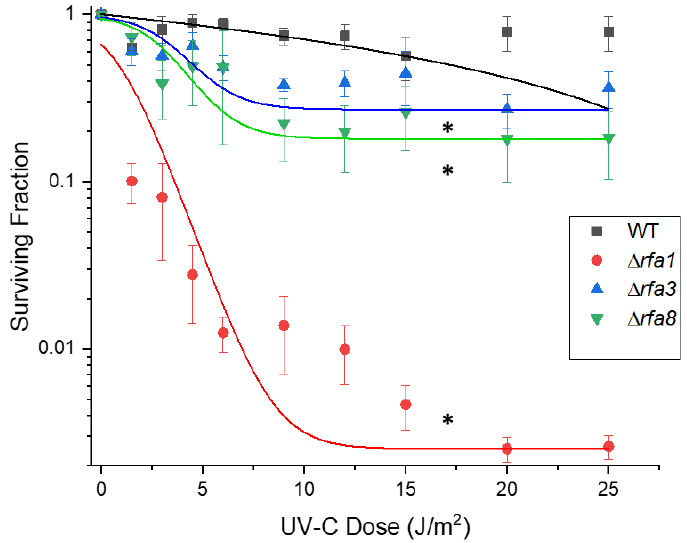
Figure 5. Survival of Hbt. salinarum deletion strains to UV-C damage. LH101 (WT), LH140 ( ∆ rfa1 ), LH134 ( ∆ rfa3 ), and LH136 ( ∆ rfa8 ). * p < 0.05 compared to LH101; ANOVA with Tukey’s HSD, n = 3. Error bars represent +/ − standard error of the mean. Mutant strain survival curves were fitted to the Boltzmann function in Origin 2018 (OriginLab, Northampton, MA, USA).